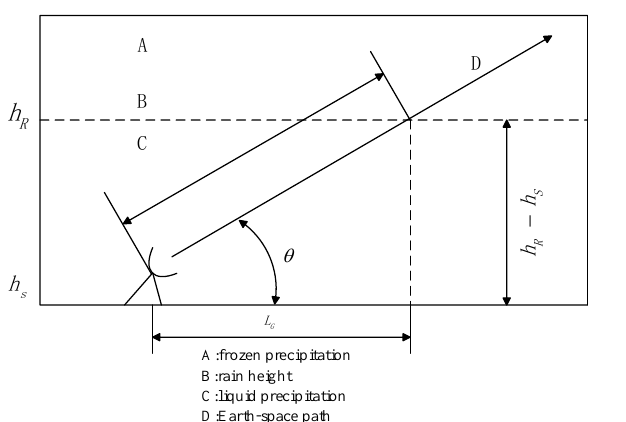
Figure 4. Diagram of an Earth-space path.